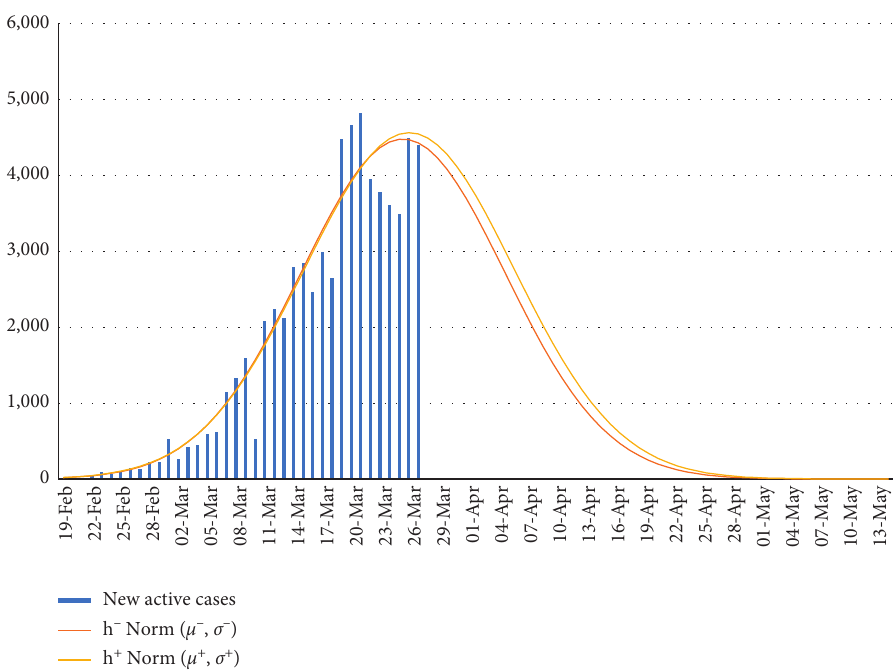
Figure 4: COVID-19 new active cases fitting with